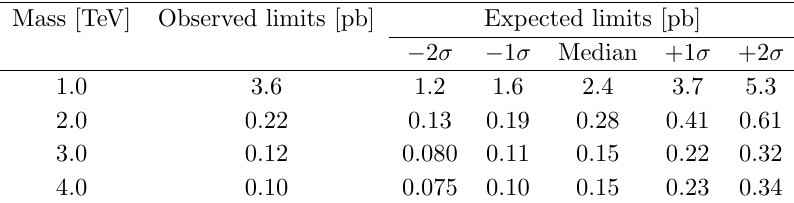
Table 8 . Expected and observed cross section limits at 95% CL, for the 30% width Z 0 resonance hypothesis.